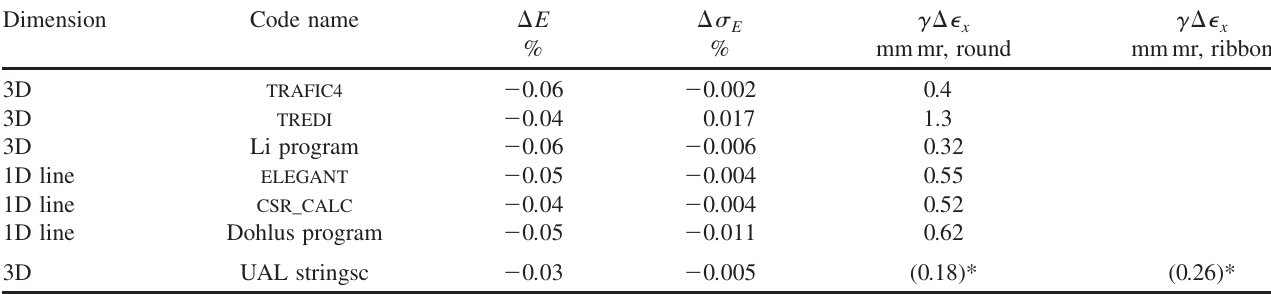
TABLE V. List of benchmarked codes giving the beam parameters at the output of the chicane (from Giannessi) [31]. Results in the bottom row are from the present simulation. For the ‘‘round beam’’ (cid:4)(cid:1) x ¼ (cid:4)(cid:1) y ¼ 1 mm mr . For the ‘‘ribbon beam’’ the vertical emittance is reduced by a factor 100. The entries marked with * have been extrapolated to infinitesimal charge per macroparticle to suppress emittance growth due to halo coming from granularity of the beam in the simulation. This reduces 0.35 to 0.18 and reduces 3.26 to 0.26. The halo is an artifact of the simulation resulting from close encounters of macroparticles in the simulation. The quite small number of halo particles has a disproportionate influence on the emittance, but would have little effect on luminosity in colliders or beam brilliance in x-ray sources. It is unclear whether a distinction between core and halo has been applied to any of the other entries in the table.